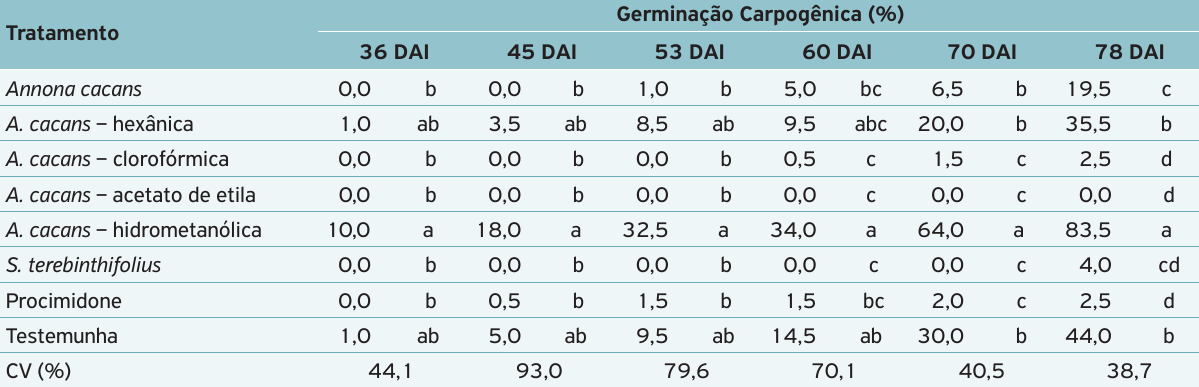
Tabela 3. Germinação carpogênica (%) de S. sclerotiorum sob extratos metanólicos (1.000 ppm) de Anonna cacans , Schinus terebinthifolius , frações (100 ppm) hexânica, acetato de etila, hidrometanólica e clorofórmica de Anonna cacans e